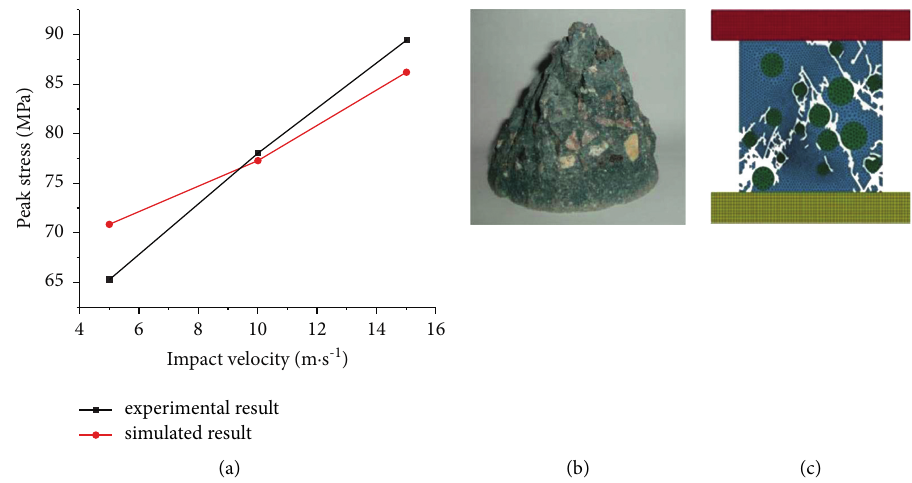
Figure 7: Comparison of single-graded concrete between experimental and simulated